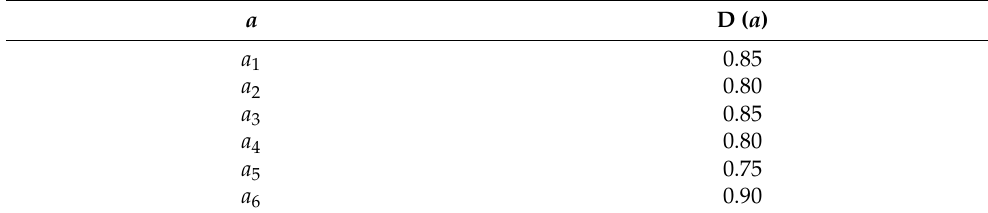
Figure 1. Example of an AOA BN with 5 nodes. Table 1. State distributions in Figure 1.